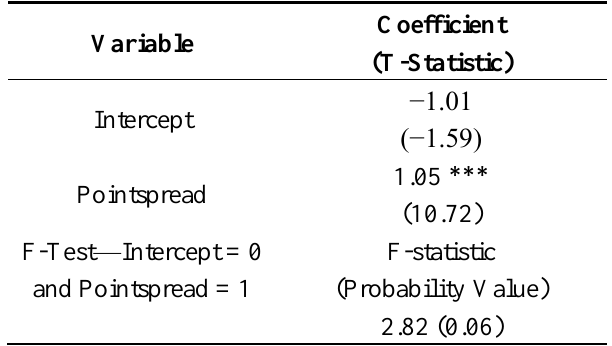
Table 2. Regression Results—Efficiency Test—WNBA. Dependent Variable: Score Differential (Favorite Score—Underdog